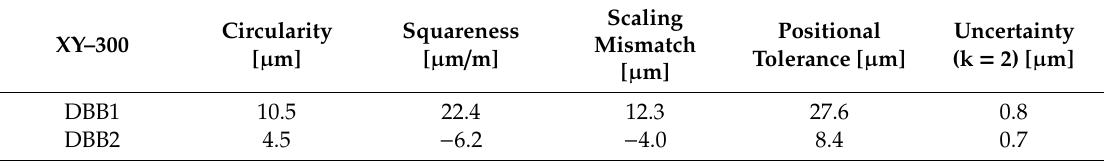
Figure 8. Circularity test—300 mm diameter: ( a ) without volumetric compensation; ( b ) with volumetric compensation. Table 8. Results of the circularity test—300 mm diameter.